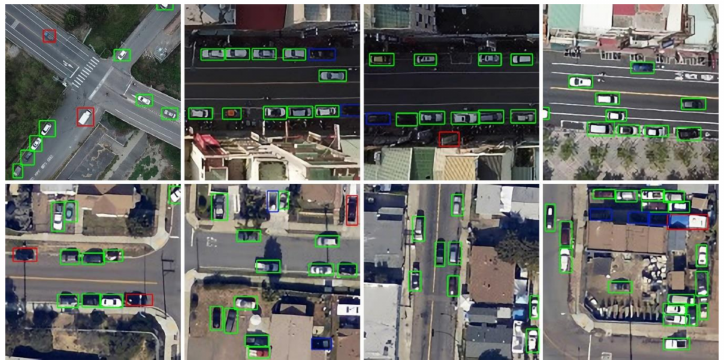
Figure 13. Detection on an independent dataset for an IoU of 0.10. Green —True Positive, red —False Positive, and blue —False